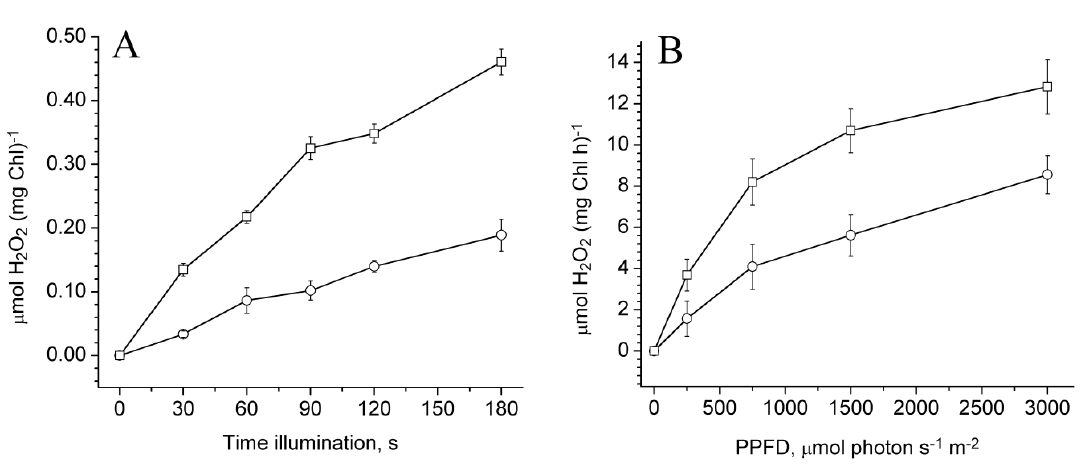
Figure 3. H 2 O 2 photoproduction in untreated ( ) and Mn-depleted PSII core complexes ( ). ( A ) Dependence of H 2 O 2 photoproduction in the PSII core complexes on the duration of illumination ( λ > 600 нм, 1500 µmol photon s −1 m −2 ). ( B ) Dependence of H 2 O 2 photoproduction in the PSII core